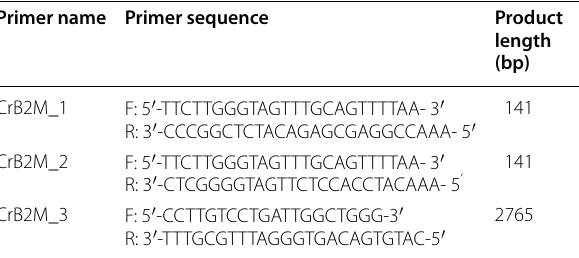
BME and BMI indicate the gRNAs targeting exon 1 and intron 1 respectively